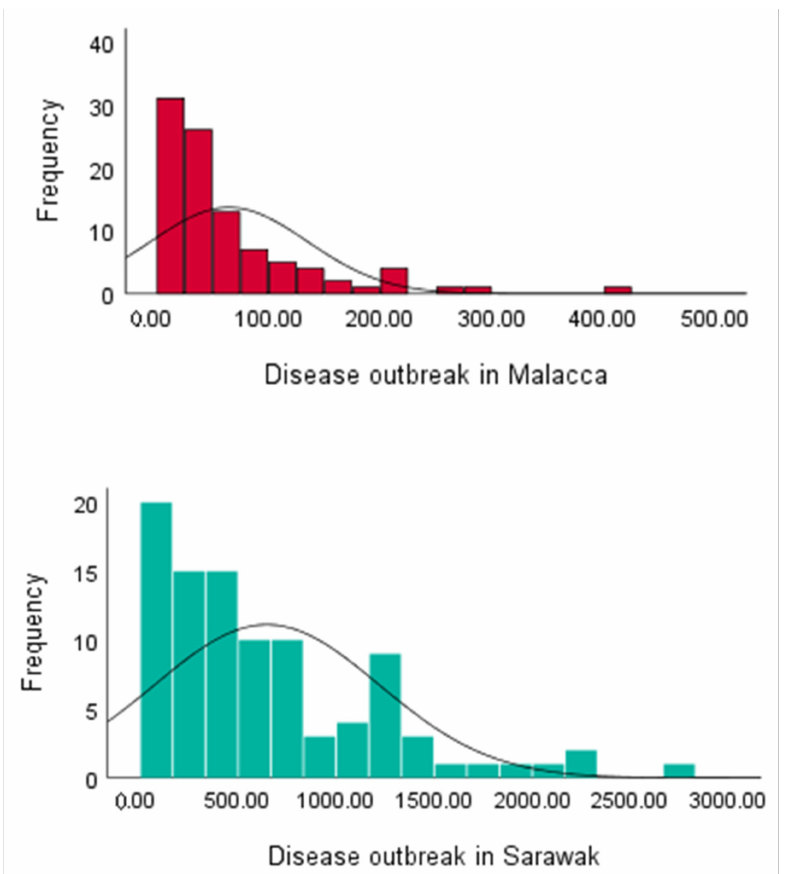
Figure 5. The humidity and the scale of mouth, foot and hand disease outbreak in Sarawak and Malacca.